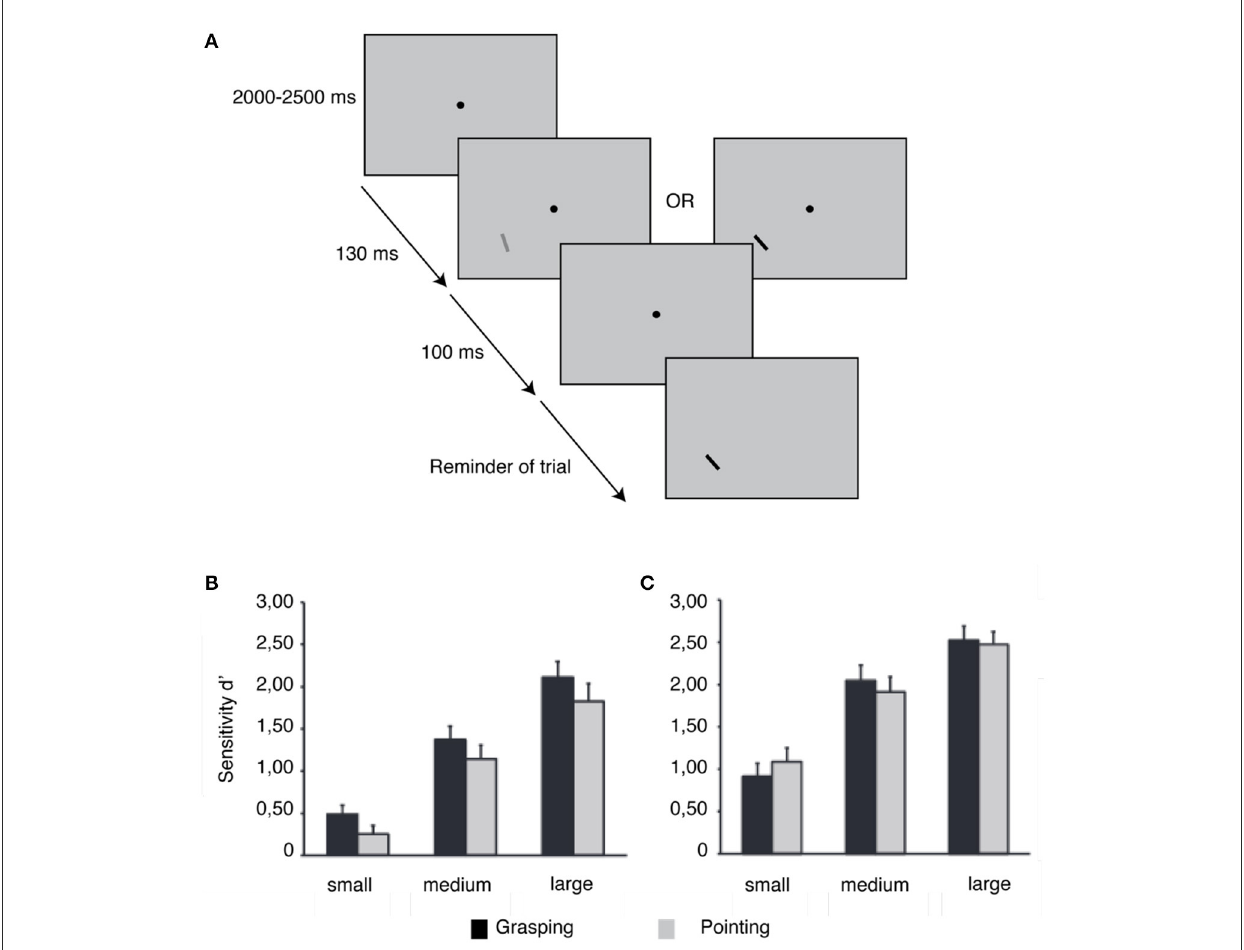
FIGURE2 Effect of grasping and pointing planning on orientation and luminance detection. (A) Experimental approach. Experiments 1 and 2 used a similar stimulus display, which included a fixation spot and two bars. Participants were instructed to execute an action after a go-cue signaled by the appearance of the first bar. The second bar was either rotated slightly (Experiment 1) or differed in luminance (Experiment 2) from the first bar. (B) In Experiment 1, participants showed better orientation discrimination when planning a grasping action rather than when planning a pointing action. (C) Experiment 2 did not reveal any consistent change in luminance discrimination between grasping and pointing planning. Modified from Gutteling et al.